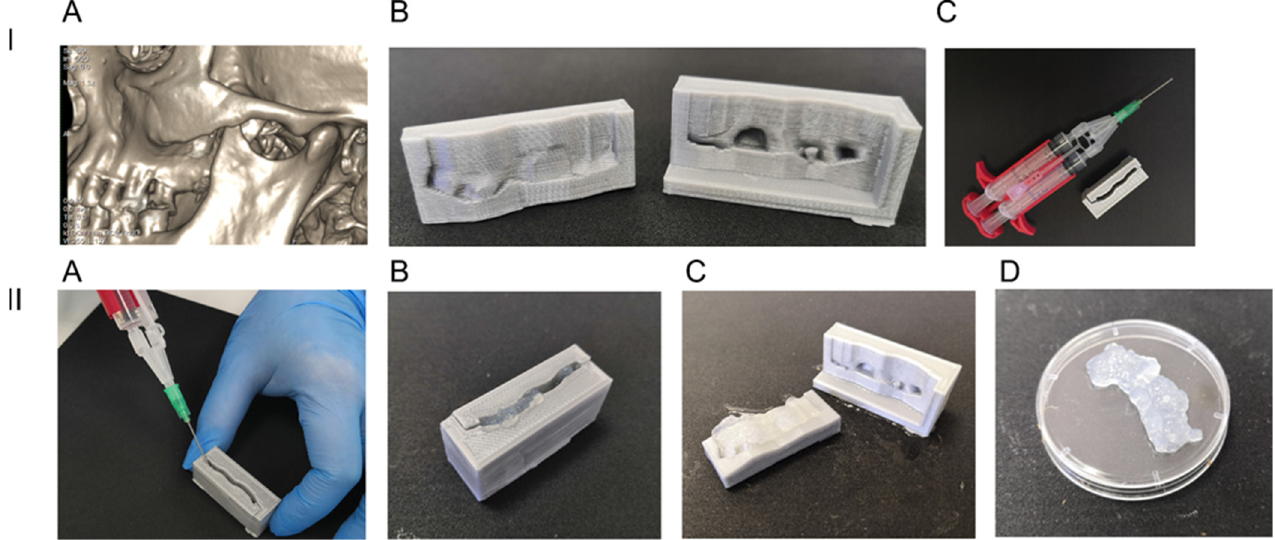
Figure 1. 3D molding form and preparation of anatomical cell-seeded scaffold. Panel I. ( A ) a jaw and teeth 3D model reconstructed on CT data; ( B ) vestibular and alveolar parts of a 3D printed molding form; ( C ) an assembled molding form and a Duploject™ application system for fibrin glue application. Panel II. ( A ) Filling the form with fibrin gel. One syringe was filled with cryoprecipitate, the second one with 2× thrombin solution with resuspended DPSC; ( B ) an assembled form filled with DPSC-seeded fibrin gel; ( C ) the form opened after gel polymerization (approx. 1–3 min); ( D ) A DPSC-seeded fibrin gel matching the bone defect.